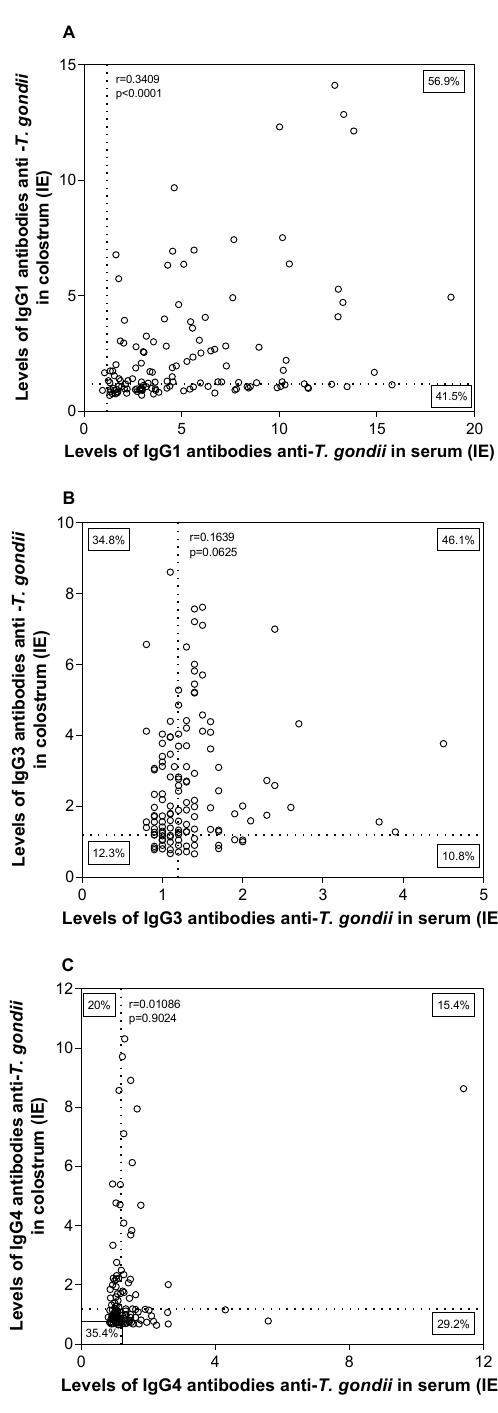
Figure 3. Correlation between levels of IgG1 ( A ), IgG3 ( B ), and IgG4 ( C ) antibody subclasses against T. gondii . Data determined by ELISA index (IE) present in paired serum and colostrum samples of 130 puerperal women. Dashed lines indicate the positivity cut off value (IE > 1.2). Double- positive, double-negative, or single-positive percentages are indicated in each corresponding corner. Correlation coefficients ( r ) were calculated by Spearman correlation test ( p <